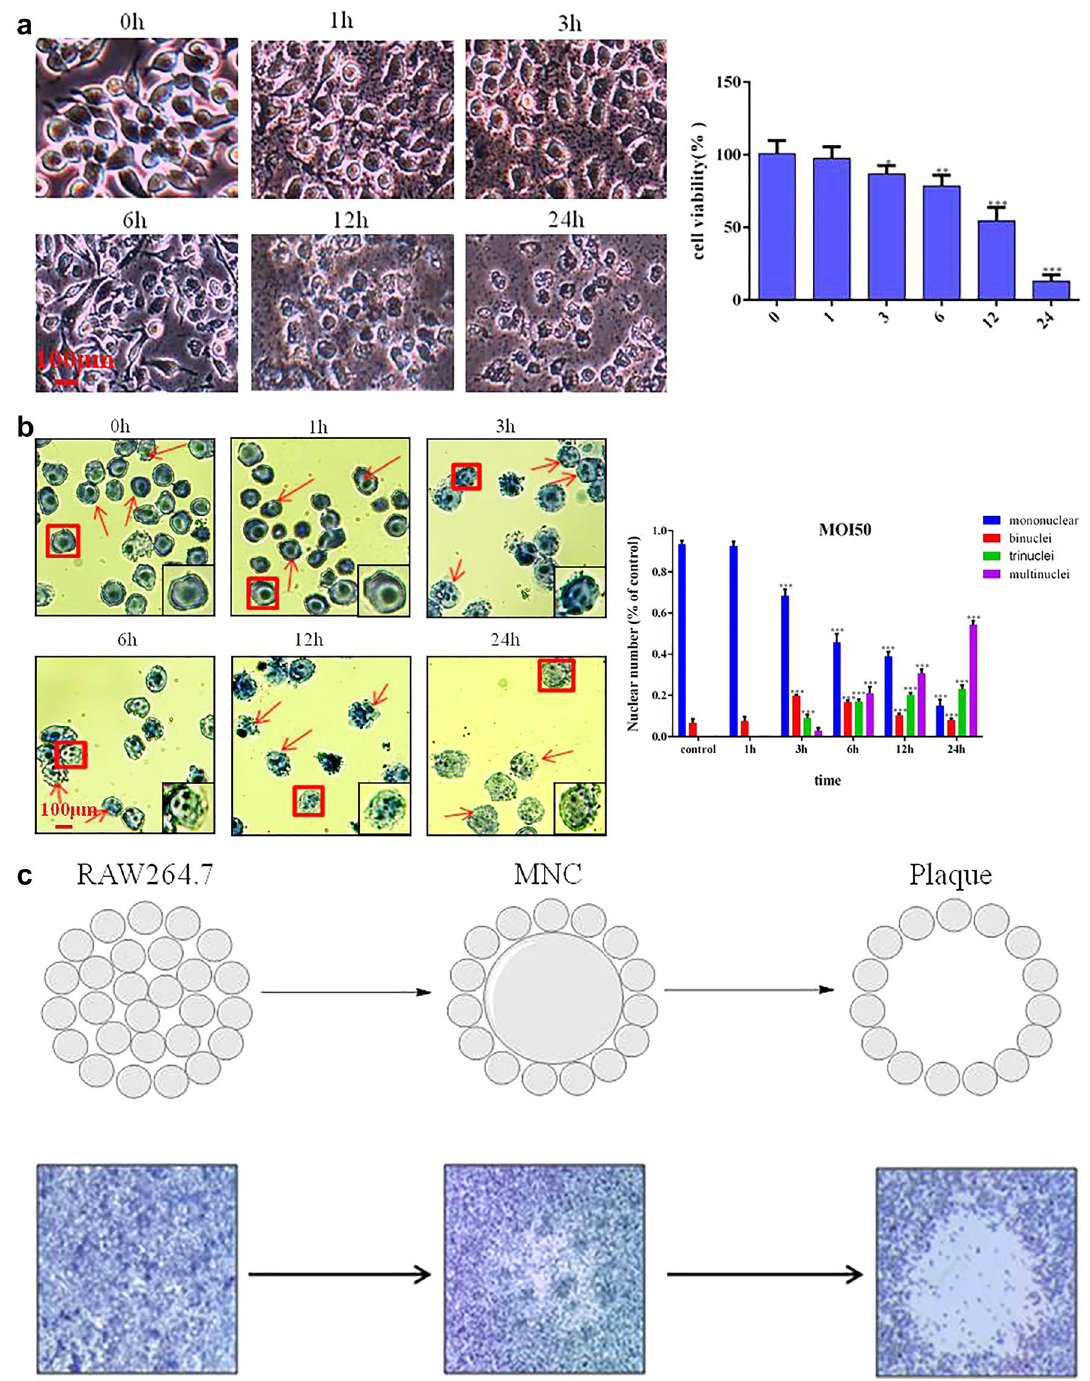
Figure 1. RAW264.7 cell B. pseudomallei HNBP001 infection model. ( A ) RAW264.7 cells were infected with B. pseudomallei HNBP001 MOI 50 at 0, 1, 3, 6, 12, or 24 h; cell morphology was observed under the microscope; and quantification of cell viability was indicated. ( B ) RAW264.7 cells were stained with Giemsa, and MNGCs were counted. Quantification of MNGCs was indicated. Mononuclear means the number of cells only with one nuclear, binucleus means the number of cells with two nuclei, trinucleus means the number of cells with three nucleus, and the multinuclus means the number of cells with more than three nucleus. ( C ) Cell fusion assay with example well images show RAW264.7 cell monolayers infected with B. pseudomallei HNBP001 and stained with Giemsa. ( D ) The relative abundance and size of plaques while infected with B. pseudomallei HNBP001 was assessed at different MOI or times. We conducted the same experiment three times